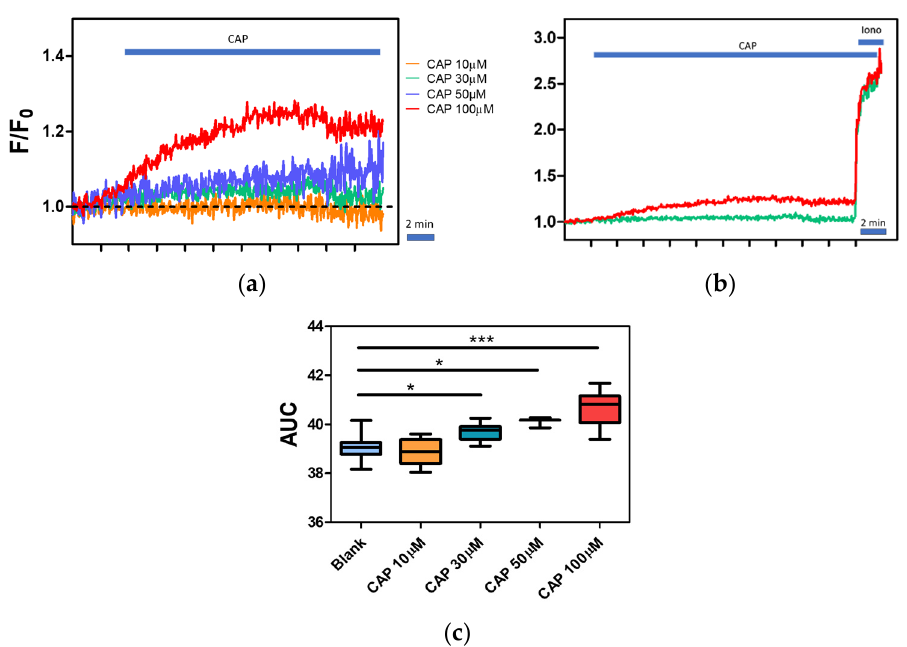
Figure 6. Capsaicin dose–response of the canine PBMC. ( a ) Calcium traces of the canine PBMC treated with different CAP doses. An increase in fluorescence intensity was observed with increasing agonist (CAP) concentration. ( b ) Administration of ionomycin in the final concentration of 1ng/mL led to a further increase in fluorescence intensity. ( c ) Significant increase in intracellular calcium levels was observed in groups treated with 30, 50, and 100 µM CAP concentrations when compared to control. No effect was observed in the group treated with 10 µM CAP. Data are shown as a dot plot with mean ± s.e.m of AUC (from first 2 min), n = 3–8. Significant differences were denoted with asterisks, depending on the p- level: * p < 0.05, *** p < 0.0001 (one way ANOVA, followed by Tukey’s post hoc).